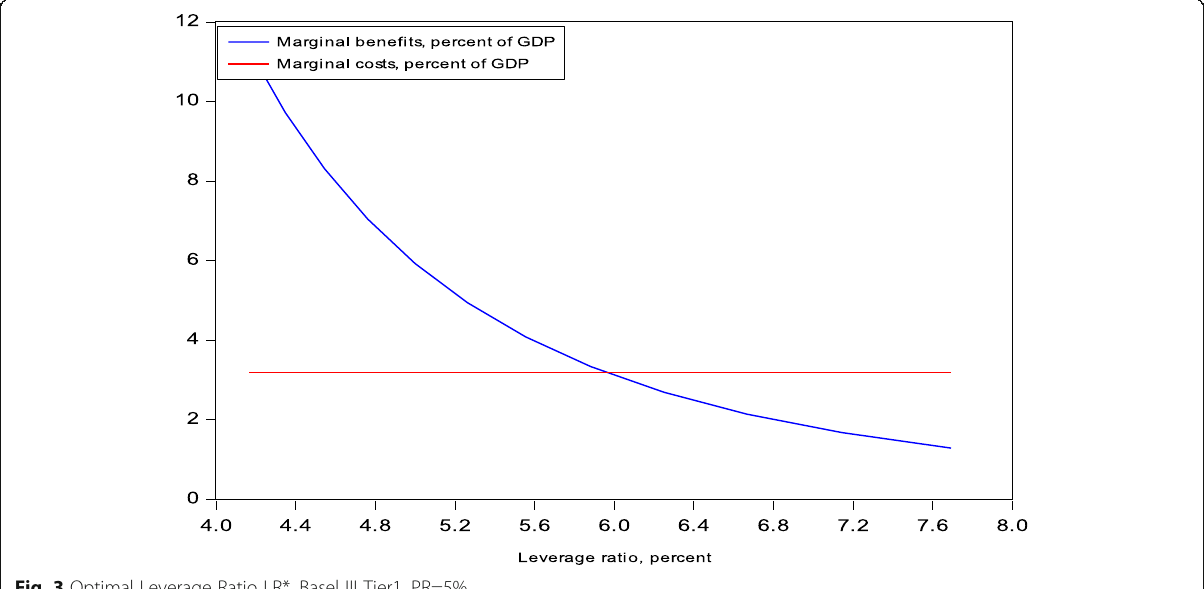
Fig. 3 Optimal Leverage Ratio LR*, Basel III Tier1,